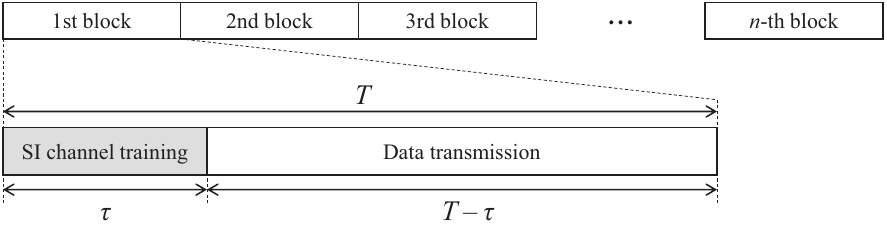
Figure 2. Frame structure for FD massive MIMO